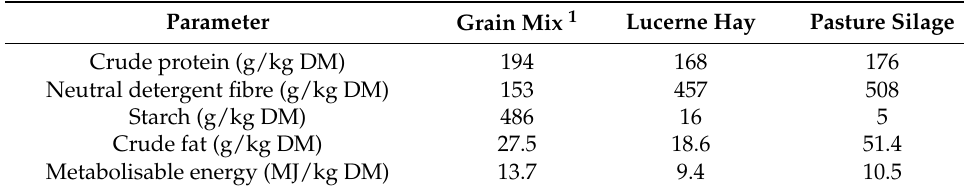
Table 1. Composition of the main dietary ingredients used in the animal experiment (as published by Williams et al. 2021). Parameter Grain Mix 1 Lucerne Hay Pasture Silage Crude protein (g/kg